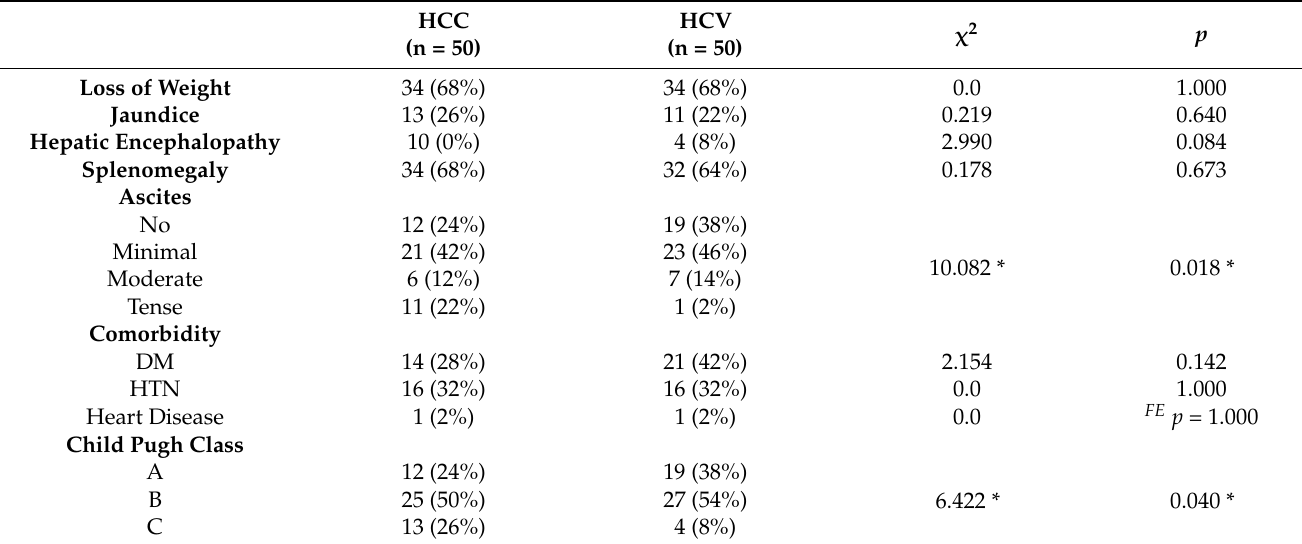
Table 2. Clinical data in the two patients’ groups (HCC & HCV).